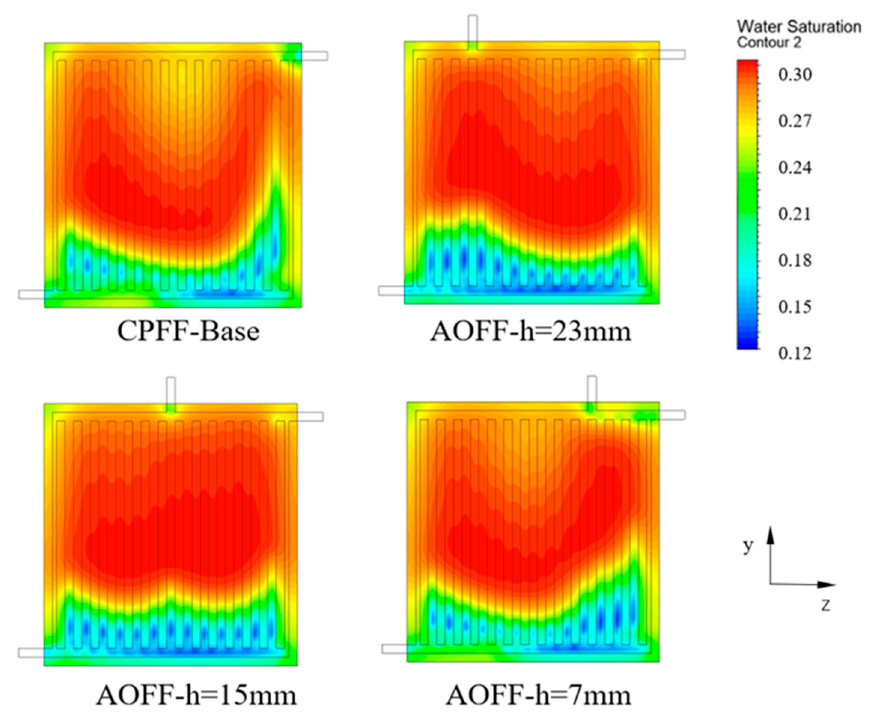
Figure 7. Water saturation on the cathode CL–GDL interface for the CPFF pattern and AOFF patterns at Vcell = 0.5 V.